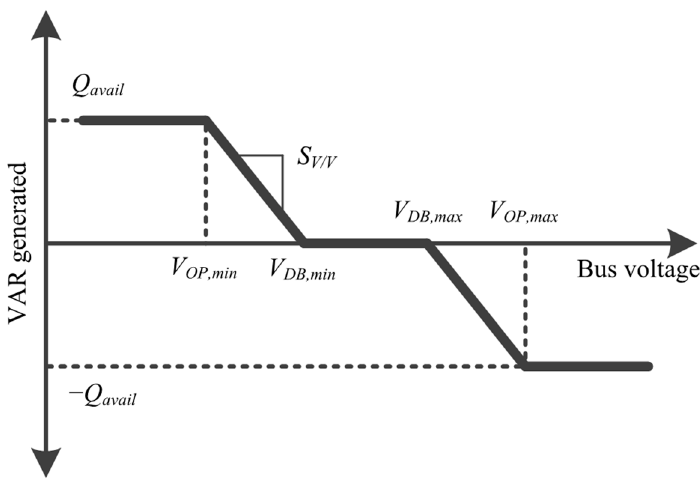
Figure 2. Voltage/VAR function requirement for smart inverters [21].